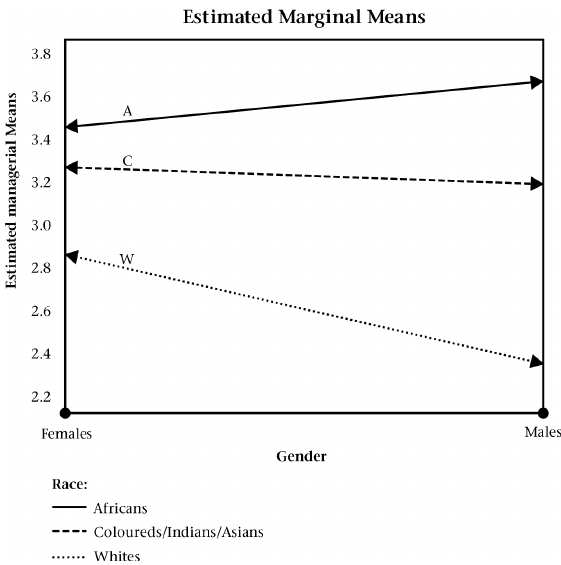
Figure 8:Biographical variables: Gender x Race as predictors of the perceptions of black economic empowerment As can be seen from Figure 8, White female employees are more positive in terms of their perceptions of black economic empowerment than white males. Coloured/ Indian/Asian and African male and female employees are equally positive in terms of their perceptions of black economic empowerment, but more than White male/ female employees.